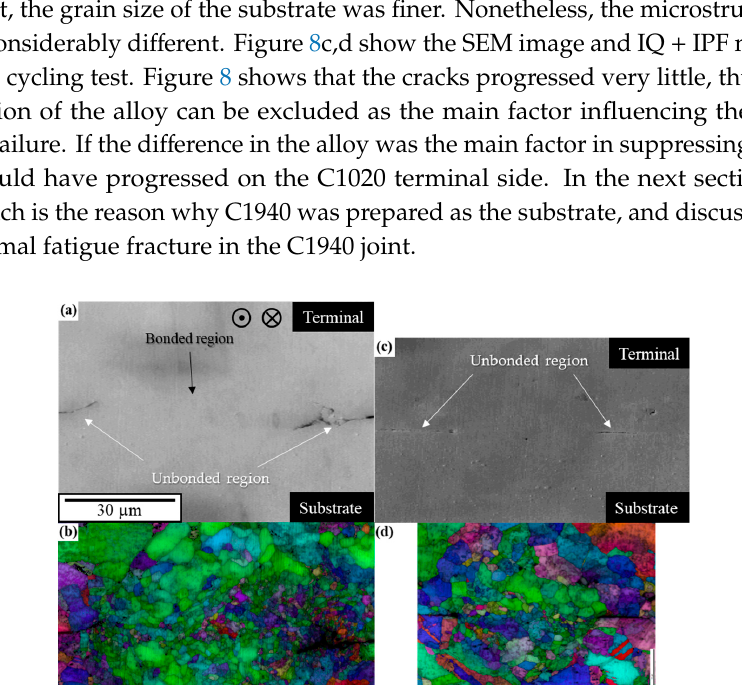
Figure 8. EBSD results of the cross-section of C1940 joints perpendicular to the ultrasonic vibration. ( a , c ) SEM images and ( b , d ) IQ + IPF maps of the joints before and after thermal cycling tests,